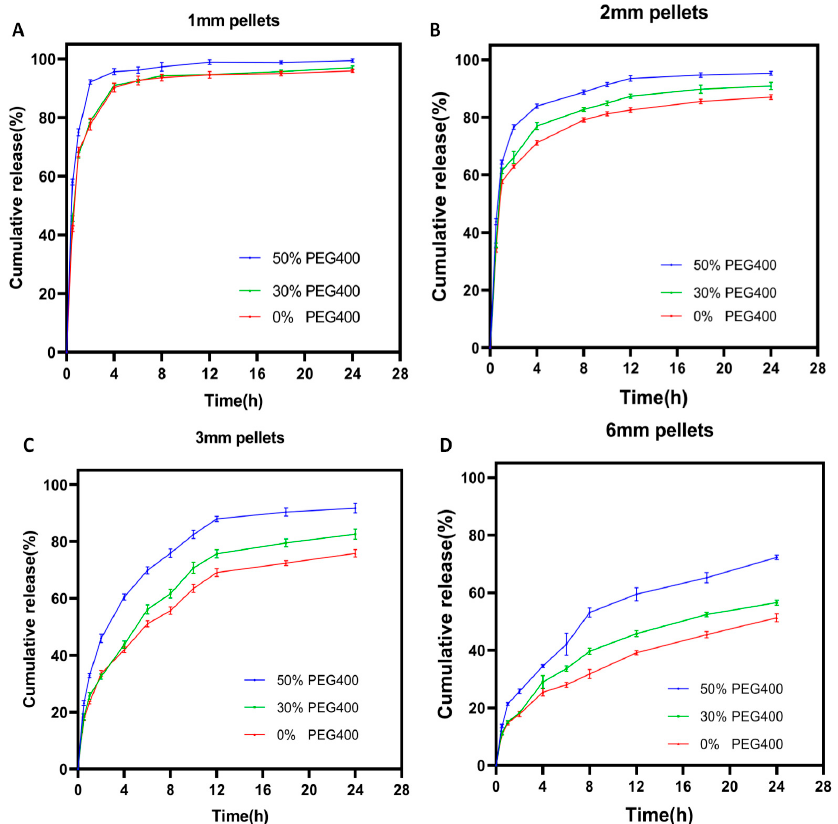
Figure 8. Drug dissolution profiles for different sized SLA-printed pellets: ( A ) 1 mm pellets; ( B ) 2 mm pellets; ( C ) 3 mm pellets; ( D ) 6 mm pellets.